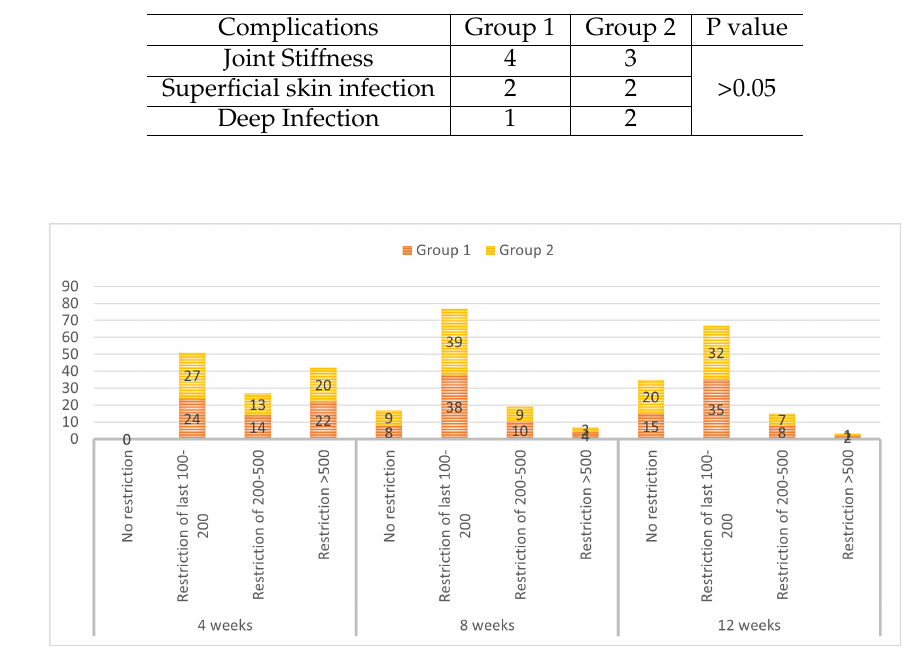
Figure 2. Comparison of